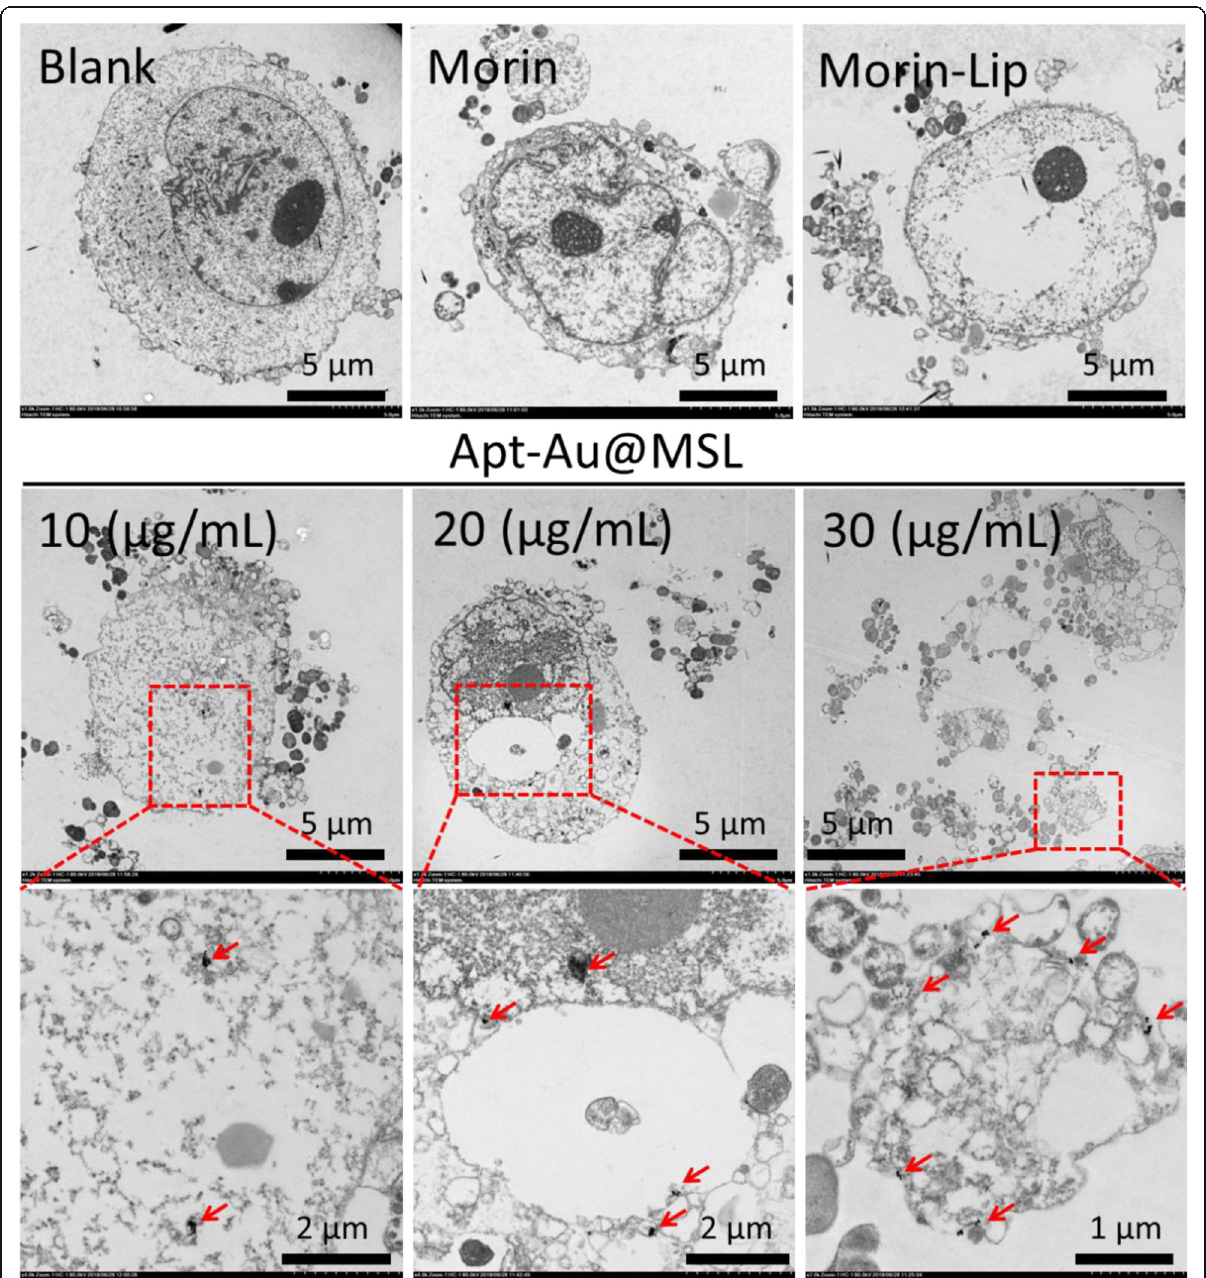
Fig. 7 TEM images of SGC-7901 cells treated with different concentration of Apt-Au-MSL (10, 20, and 30 μ g/mL). The blank group was PBS. The Morin and Morin – liposome were set as control group. The red square is the enlarge area. The red arrow point to Au